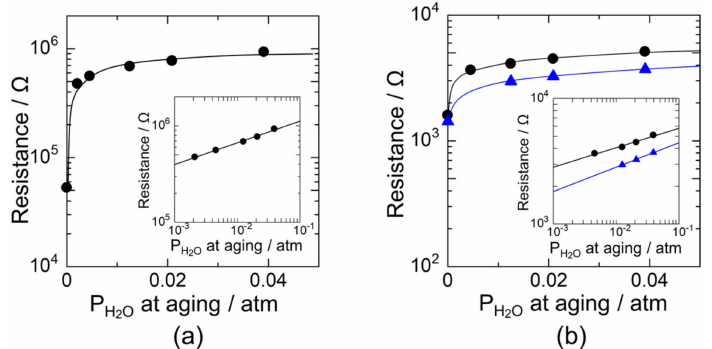
Figure 3. The electrical resistance of SnO 2 nanoparticles in ( a ) dry and ( b ) wet air atmosphere at 350 ◦ C as a function of P H2O in humid aging. P H2O in wet air atmosphere are 0.005 and 0.01